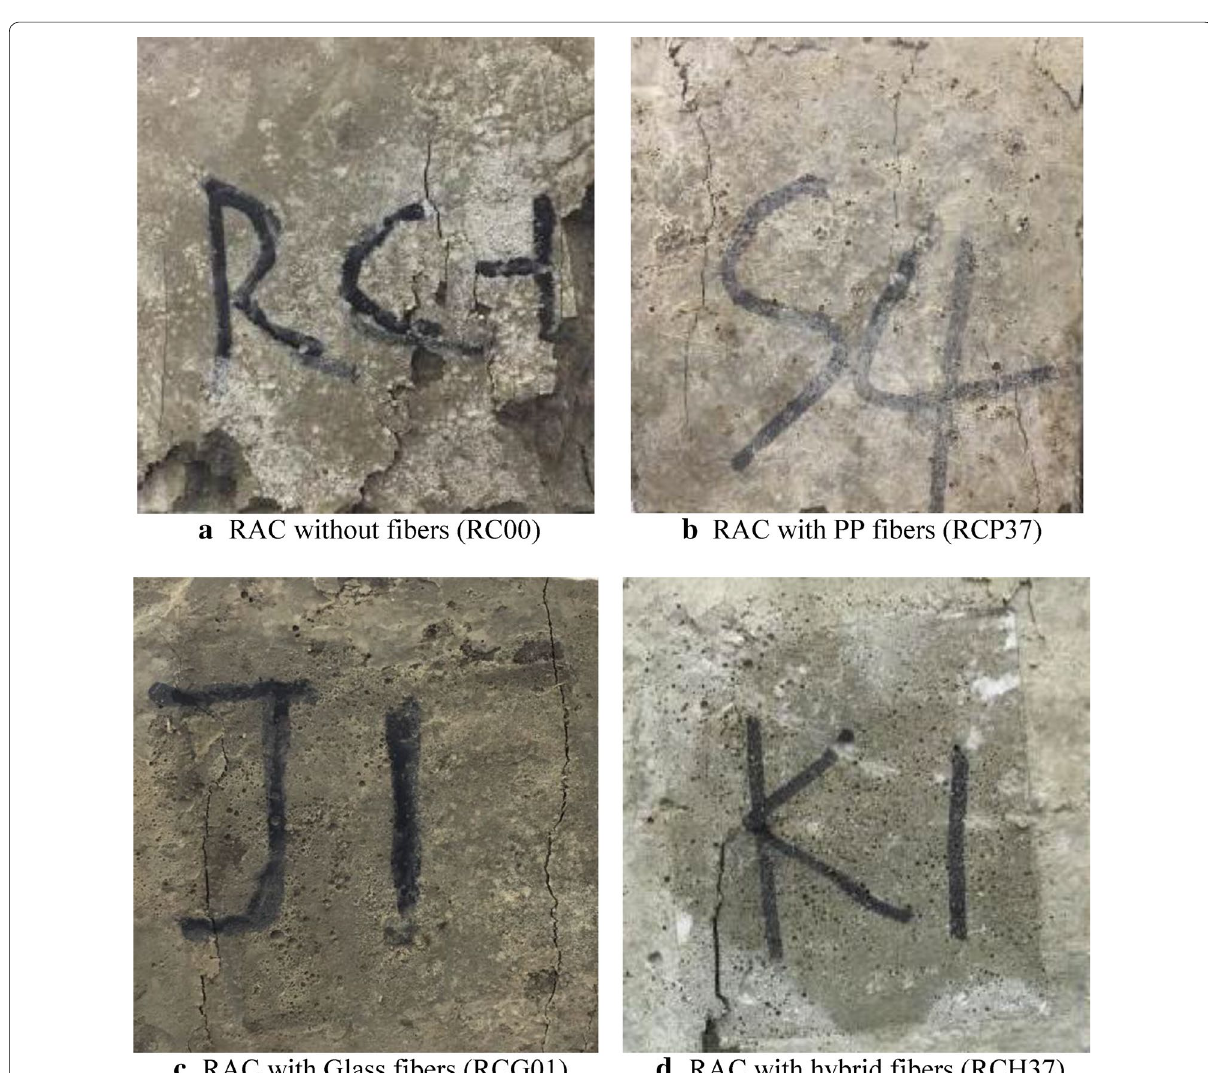
Fig. 5 Failure patterns of RAC under compression: a RAC without fibers and b RAC with